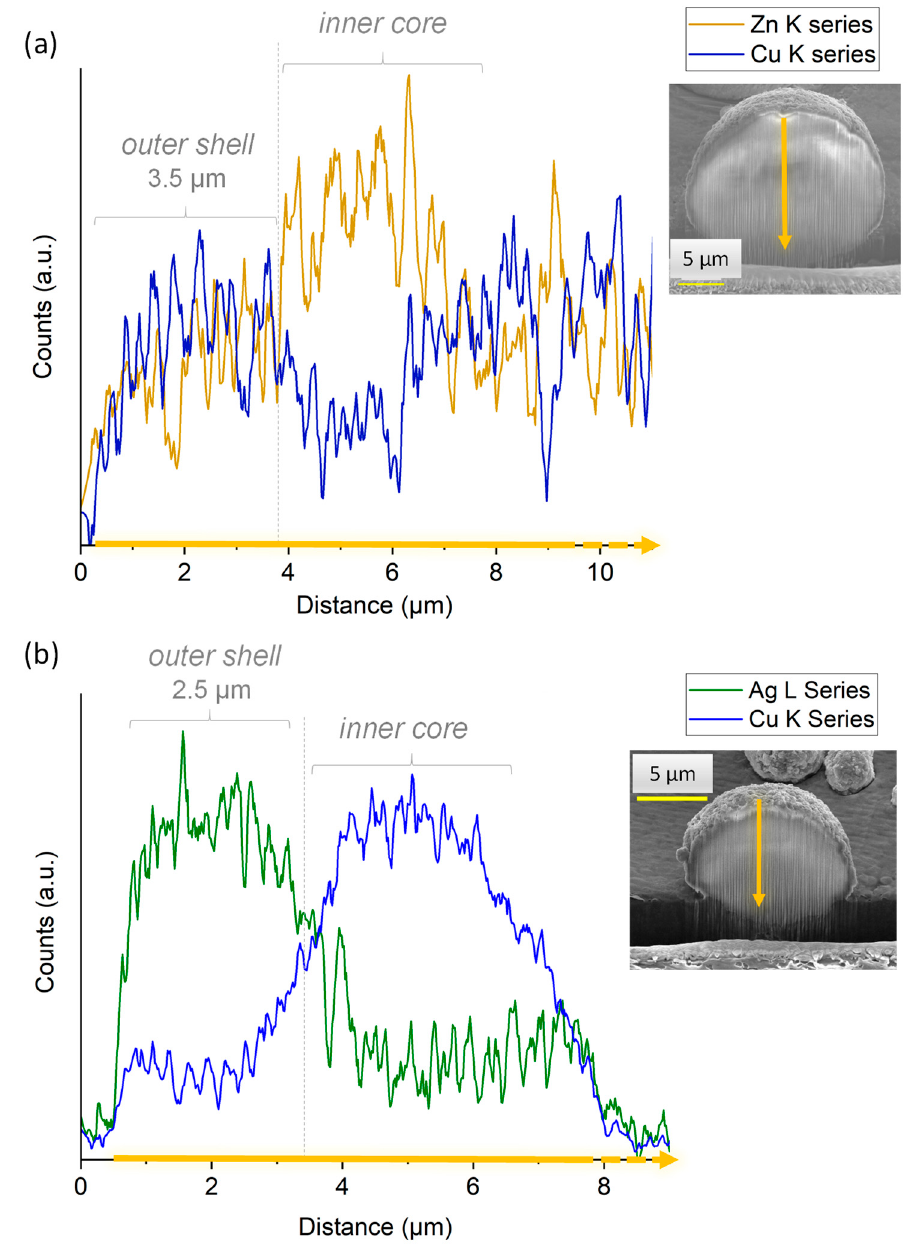
Figure 6. EDS analyses of ( a ) [(Zn 2+ )Cu 2+ ] and ( b ) [(Cu 2+ )Ag + ] particles cross-sections generated in situ by FIB milling with Ga + ions.